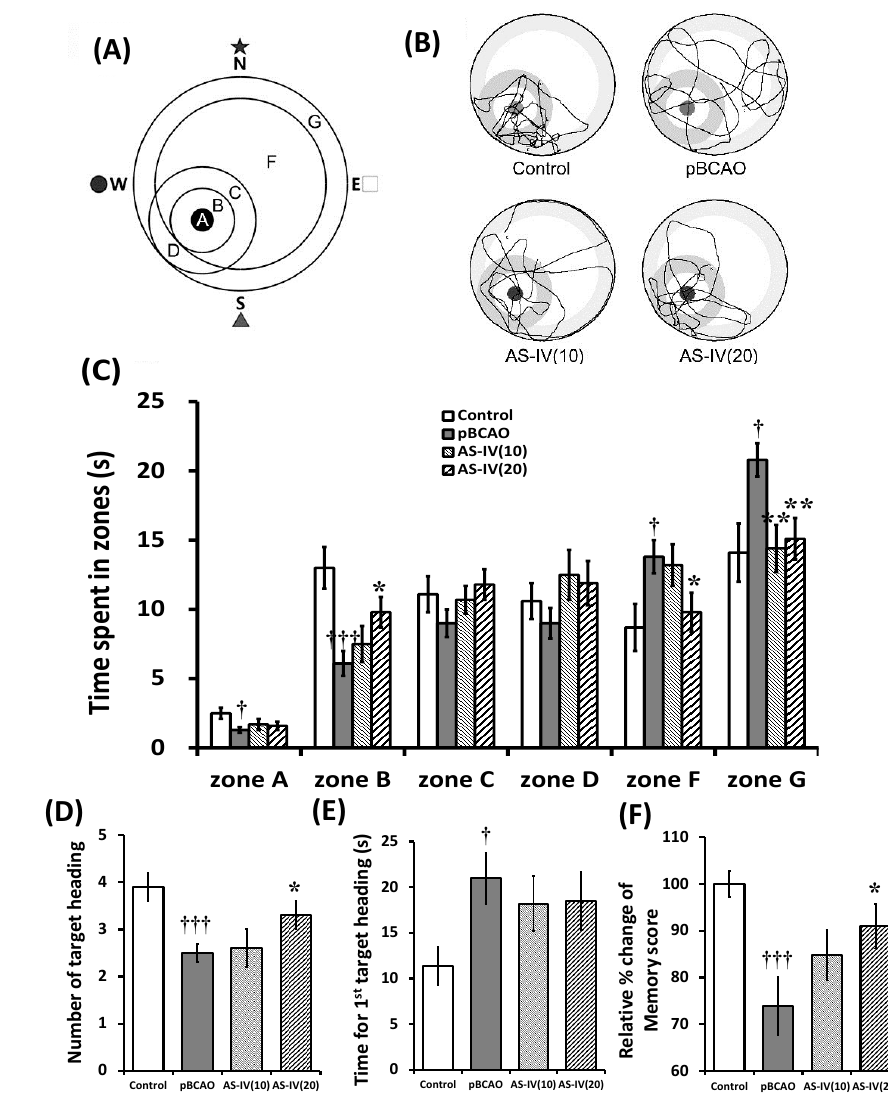
Figure 3. Effects of astragaloside IV (AS-IV) on the retention test. Computerized grid design which used in the retention test ( A ). Discrete zones are labeled with letters, zone A representing the platform site. Representative swimming tracts in study groups ( B ). AS-IV on the swimming time spent in discrete zones ( C ). AS-IV significantly prolonged the swimming time spent in zone B and significantly shortened it in zones F and G at a dose of 20 mg/kg. AS-IV significantly increased the number of target heading on platform site ( D ) and memory score ( F ) in the retention test at 20 mg/kg administration. The time for 1st target heading was not different ( E ). Data are presented as mean ± SEM ( n = 12 in each group; † , p < 0.05; ††† , p < 0.001 between the control and the pBCAO groups; * , p < 0.05; ** , p < 0.01 between the pBCAO and AS-IV